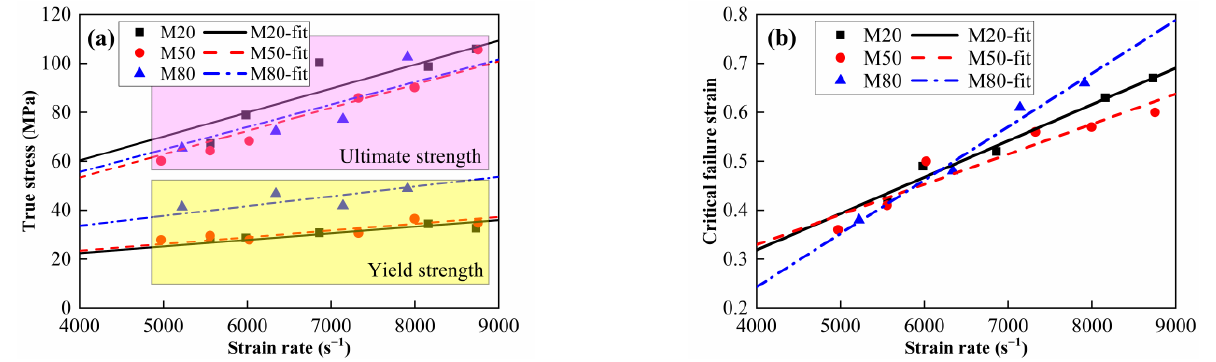
Figure 14. Strain rate effect on yield strength, ultimate strength and critical failure strain of the material with different W contents. ( a ) Strength and ( b ) critical failure strain.